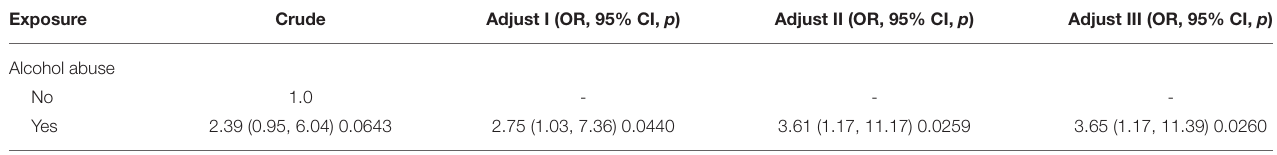
TABLE 4 | Relationship between alcohol abuse and angiographic vasospasm in different models by multivariable logistic regression analysis. Exposure Crude Adjust I (OR, 95% CI, p ) Adjust II (OR, 95% CI, p ) Adjust III (OR, 95% CI, p )